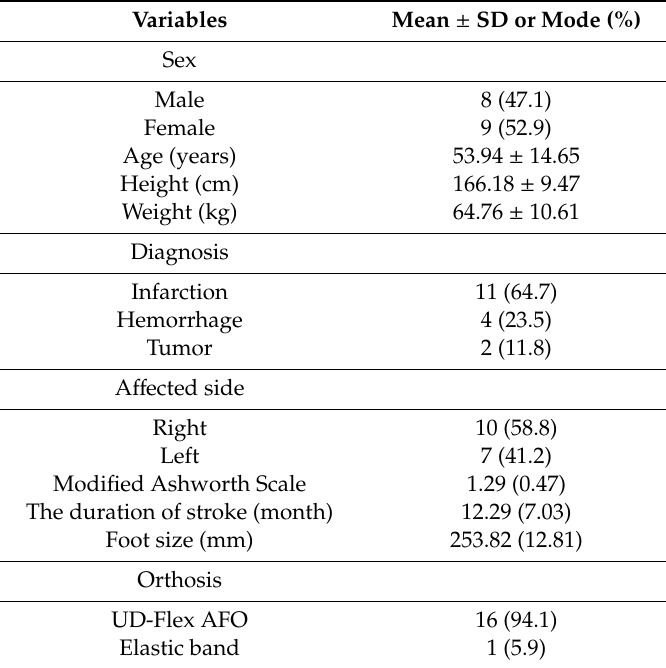
Table 2. Static balance using Zebris.